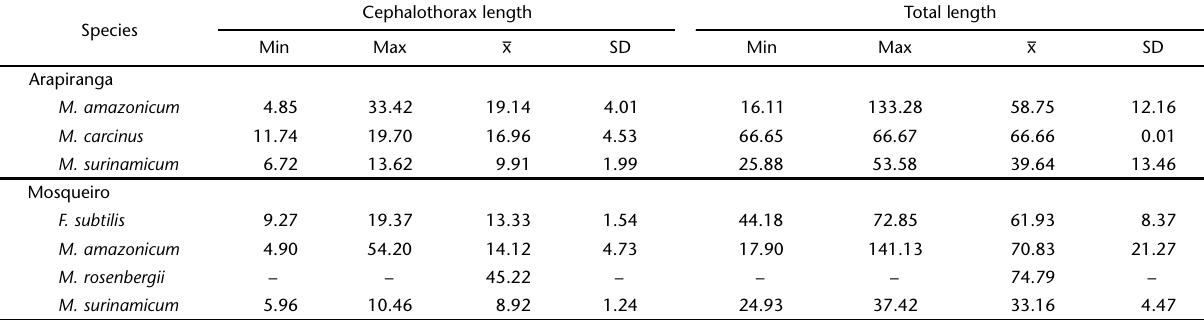
Table II. Descriptive statistics of cephalothorax length (CL) and total length (TL) (mm) of shrimp species on Arapiranga Island and Mosqueiro Island. Amazon estuary of Pará. (Min) Minimum, (Max) maximum, ( x ) mean, (SD) standard deviation. Species